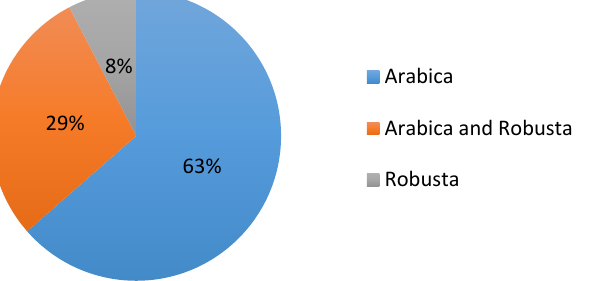
Figure 5. The coffee species reviewed in the research: 75 records, which account for 63%, considered the impact of climate change on the Coffea arabica species. In contrast, only nine documents (8%) of the research explored the effect of CC on Coffea canephora (robusta species). Thirty-four manuscripts (29%) included both species in their research.